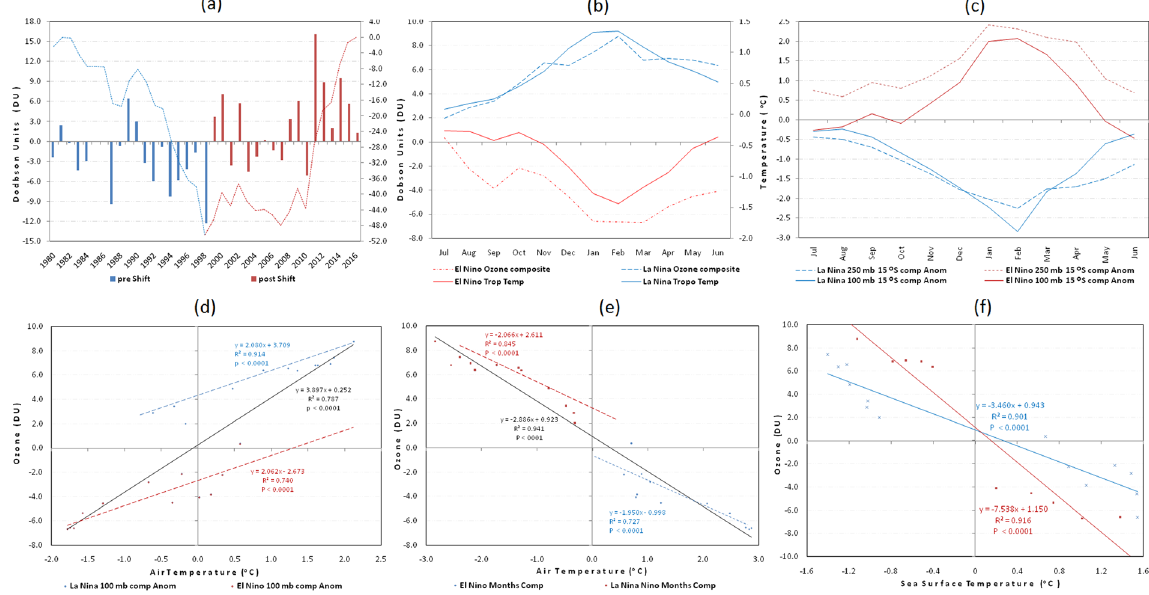
Figure 5. ( a ) Temporal manifestation of lower stratospheric ozone (bars) with the corresponding CUSUM time series superimposed (broken line). Monthly variation of the ( b ) ozone and ( c ) upper troposphere air temperature for El Nino and La Nina composites. Scatter plot for ozone against air temperature anomalies at the ( d ) 100 mb level and ( e ) 250 mb level for El Nino and La Nina composite months. ( f ) Scatter plot for zone against Nino 3.4 SST anomalies for the months August to February (blue) and March to July (brown). In the insert are the regression lines and their corresponding equations. The data is for the averaged boxed region (200°E to 220°E and 15°S to 15°N) for the period from 1980 to 2016. The ozone data are from http://www. temis.nl/protocols/o3field/o3mean_msr.php. Nino 3.4 data are from https://www.ncdc.noaa.gov/data-access/ marineocean-data/extended-reconstructed-sea-surface-temperature-ersst-v4. The air temperature and SST data are from NCEP/NCAR 32 and HadISST1 (http://hadobs.metoffice.gov.uk/hadisst/)